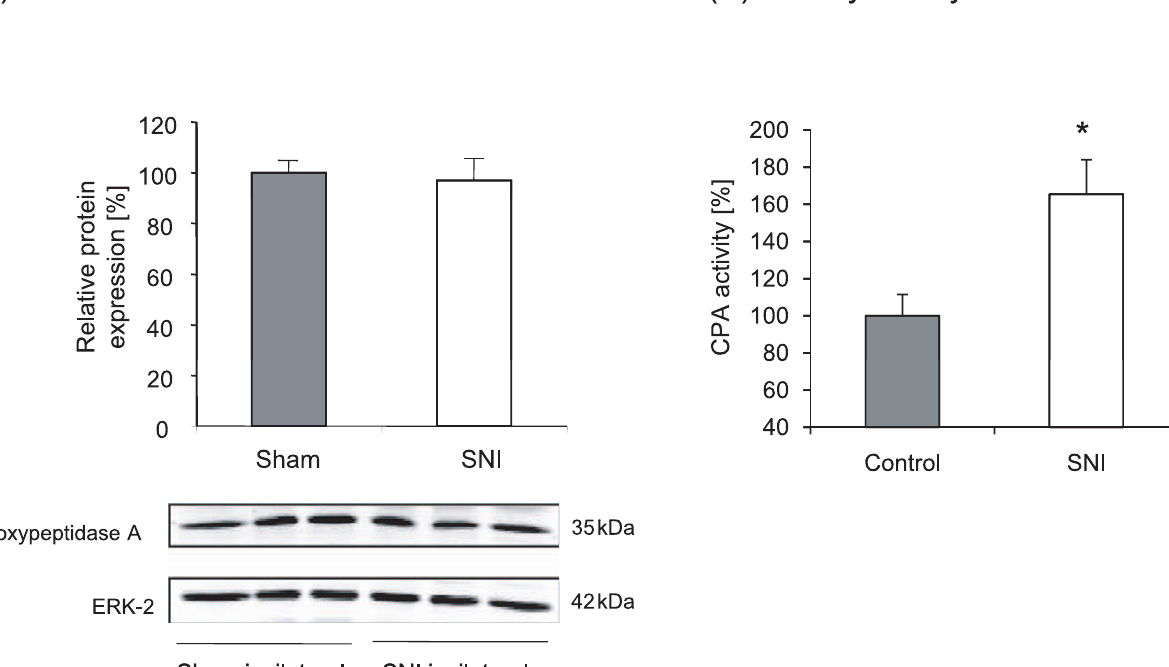
Figure 3. Carboxypeptidase A (CPA) expression and activity in the spinal cord. (A) Western Blot analysis of CPA protein levels and (B) CPA activity in the ipsilateral spinal cord of sham and SNI operated animals. Data are shown as mean 6 SEM, *P , 0.05 (n=5–6/group). For better comparison, controls are set as 100%.